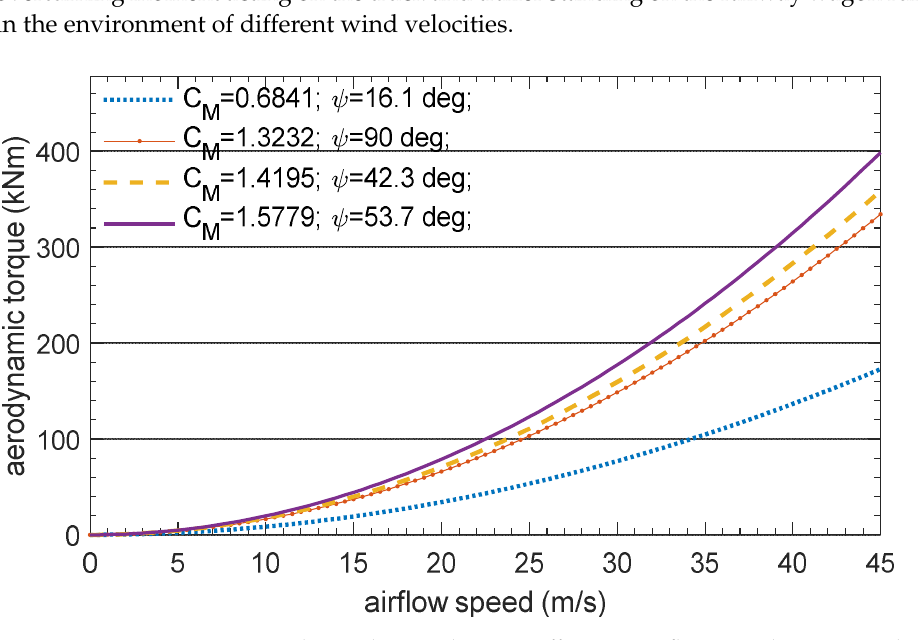
Figure 9. Overturning torque due to the aerodynamic effects vs. airflow speed, C M —aerodynamic coefficient, ψ —yaw angle of the relative airflow velocity.